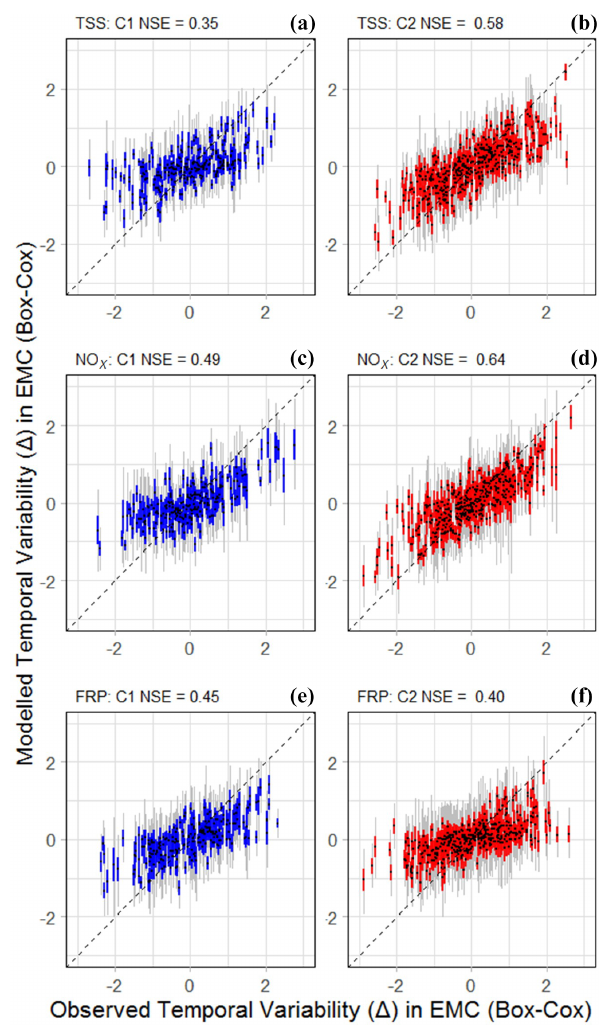
Figure 8. Performance of the BMA models of the temporal vari- ability of three constituents across 32 sites, represented by predic- tion intervals from BMA and observed Box–Cox EMC across two clusters of sites for (a, b) TSS, (c, d) NO x and (e, f) FRP. Each bar shows a single event, and all events at all sites in the cluster are included. The NSE values were calculated based on median predic- tions. Black dots show prediction median, and grey vertical lines show the 95% CI. Coloured vertical lines show the 50% CI, and blue is cluster 1 (wet) catchments, and red is cluster 2 (dry) catch- ments. Dashed black lines are the 1 : 1